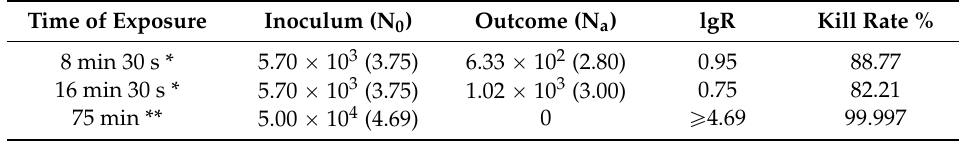
Table 2. Kill rate of Legionella pneumophila sg 1 exposed to 600 ppm Peroxy Ag + in the simulation device. Time of